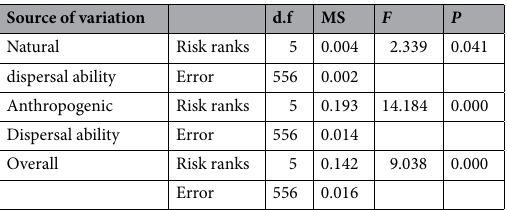
northwest regions of China (Fig. 3 Ta, Tb, Tc). The variations in dispersal ability (i.e., the differences between the highest and lowest dispersal abilities) for all alien plant species within the 34 administrative regions studied were 3.0%, 1.5%, and 2.7%, respectively, overall and in natural and anthropogenic dispersal modes (Fig. 3 Ta, Tb, Tc). In terms of the risk ranks, the variations in overall dispersal ability were 4.6%, 5.1%, 13.2%, 5.4%, 4.6%, and 3.0% for plants in ranks I, II, III, IV, V, and VI, respectively. The variations in natural dispersal ability were 3.3%, 1.9%, 7.1%, 2.1%, 1.7%, and 1.4%, respectively, for plants in ranks I, II, III, IV, V, and VI. Finally, the variations in anthropogenic dispersal ability were 4.8%, 3.9%, 13.5%, 4.9%, 5.3%, and 2.5% for plants in ranks I, II, III, IV, V, and VI, respectively. Relationships between the dispersal ability and socio‑climatic factors. The overall, natural, and anthropogenic dispersal ability of all alien plant species showed significantly negative relationships with GDP– with p < 0.01 and p < 0.05 for overall and natural dispersal ability, respectively–and MAH (Table 3). Natural dispersal ability was positively correlated with MAP ( p < 0.01) for plants in rank II, MFD ( p < 0.01) and MAT ( p < 0.05) for those in rank III, and MFD ( p < 0.01) for plants in rank V; however, it was negatively correlated with MAH ( p < 0.01) for plants in rank IV. Anthropogenic dispersal ability was positively correlated with MAP ( p < 0.01) for plants in rank I but negatively correlated with MAP ( p < 0.01), MAH ( p < 0.01), MFD ( p < 0.05), and MAH ( p < 0.01) for plants in ranks III, IV, V, and VI, respectively (Table 3). Overall dispersal ability was posi- tively correlated with GDP ( p < 0.01) and MFD (p < 0.01) for plants in ranks I and V, respectively, and negatively